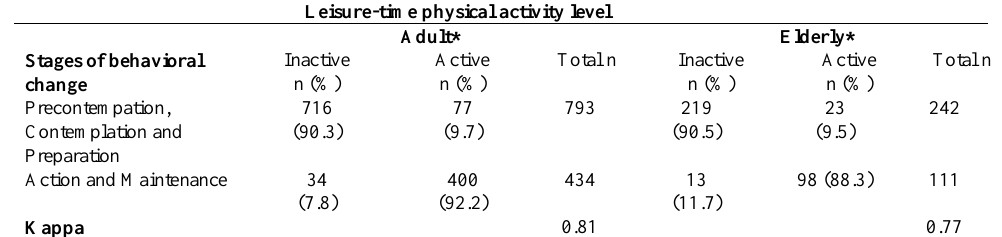
Table 3. Concordance between Stages of Behavior Change Questionnaire (SBCQ) and International Physical Activity Questionnaire (IPAQ). Data presented separated by adults and elderly.